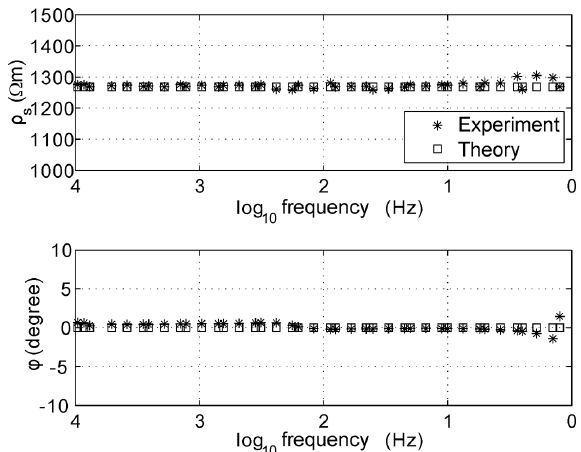
Figure 13. Comparison between the calculated results and the sim- ulation results for the CSAMT